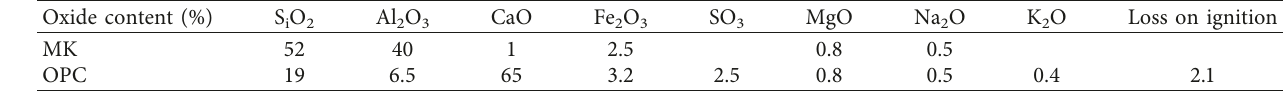
Table 2: Oxide composition of materials.